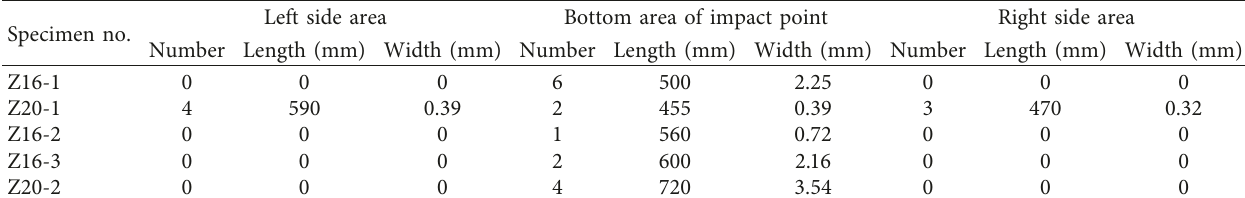
Table 8: Comparison of the numbers, lengths, and widths of the main cracks. Specimen no.